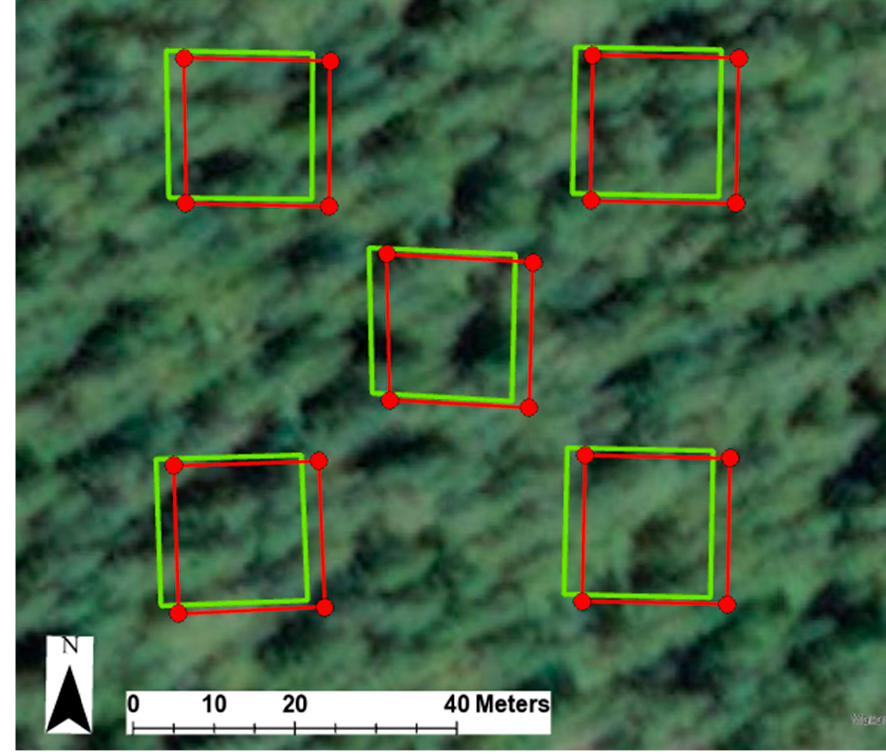
Figure 5. Example unit (containing 5 tree plots) showing the difference between the tree plot locations in the original, framework survey data and the tree plot locations using our LiDAR-based methodology. Light green rectangles represent tree plot locations from the framework survey; red rectangles represent tree plot locations after matching stem maps to LiDAR CHMs. Each unit was shifted based on the average differences between original tree plot locations and LiDAR-based locations.